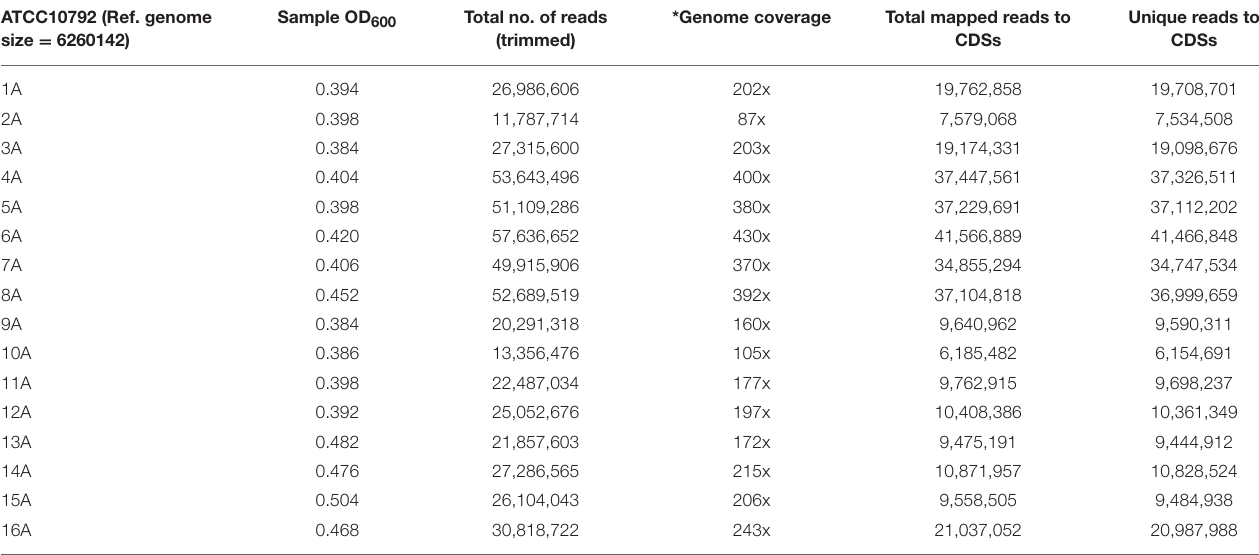
TABLE 1 | Summary of trimmed and mapped reads for strain ATCC10792. ATCC10792 (Ref. genome size = 6260142)